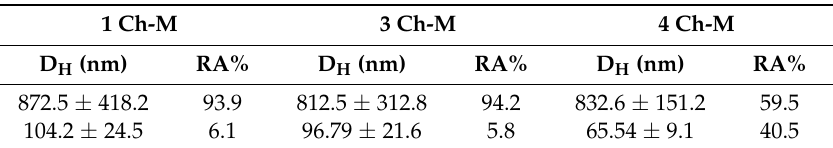
Table 2. Values of the hydrodynamic diameter (D H ) and the relative amount (RA (%)) as obtained by DLS for chitosans–Mucin (M).